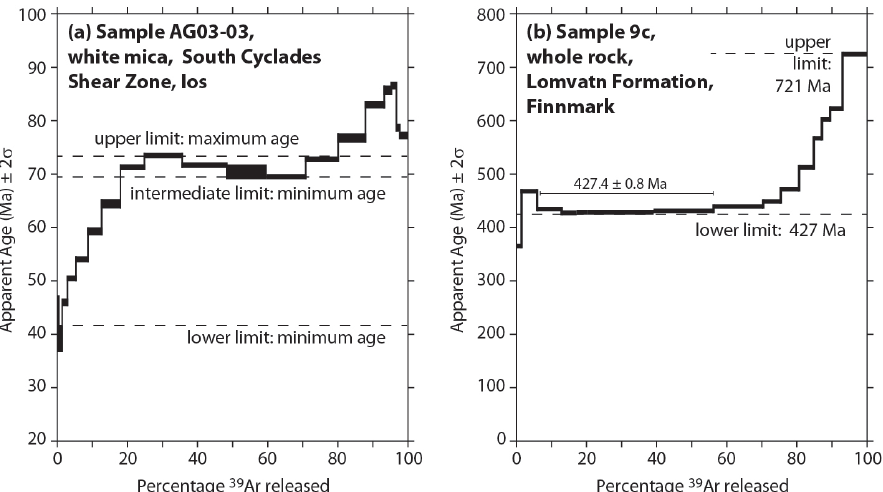
Figure 7. Examples of complex age spectra obtained from mixtures of minerals with different microstructural and microchemical composi- tions. (a) Sample of white mica from South Cyclades Shear Zone, Ios, Greece, data from Forster and Lister (2009). The data are interpreted to contain three limits. The upper and intermediate age limits are interpreted by Forster and Lister (2009) to reflect recrystallisation ages in fabrics that are relict from their earlier deformation, while the younger limit reflects partial modification of the age spectrum during Hercy- nian amphibolite facies metamorphism (ca. 45Ma). (b) Whole rock slate analysis from Dallmeyer et al. (1988). The sample contains both detrital mica and a cleavage, with the ca. 427Ma lower limit interpreted to reflect the timing of cleavage formation, while the older ages reflect the influence of detrital minerals with higher argon retentivity (Dallmeyer et al.,